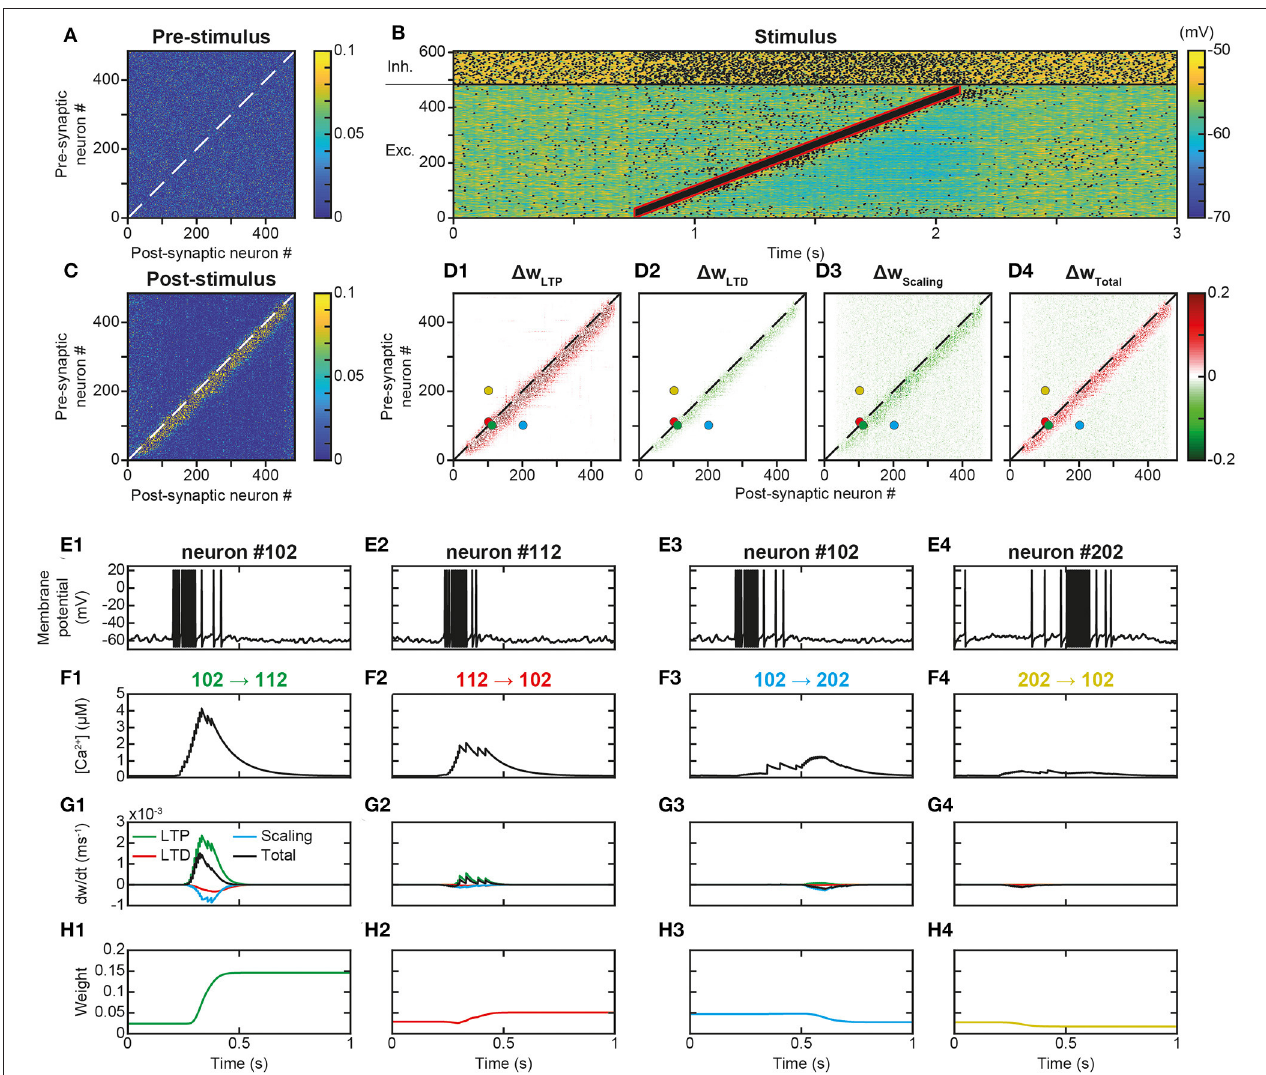
FIGURE 3 | Learning a trajectory stimulus into a trajectory engram. (A) . Synaptic matrix between excitatory neurons prior to stimulus presentation. (B) . Membrane potential of network neurons in response to the presentation of a trajectory stimulus (stimulus in red) that successively activates all excitatory neurons over a duration of 1,350ms. Spikes indicated by black dots. (C) . Synaptic matrix between excitatory neurons after stimulus presentation. (D1–D4) . Weight modifications resulting, after trajectory presentation, from t-LTP (D1) , t-LTD (D2) , scaling (D3) , and their sum (D4) . (E–H) Membrane potential (E) , calcium (F) , plastic rates (G) and synaptic weight dynamics (H) during the passage of the trajectory stimulus in a pair of neurons with nearby topographical tuning #102 (E1) and #112 (E2) and their reciprocal connections 102 112 (F1-H1) and 112 102 (F2-H2) , and in a pair of neurons with more distant topographical tuning #102 (E3) and #202 (E4) and their reciprocal → → connections 102 202 (F3-H3) and 202 102 (F4-H4) → →